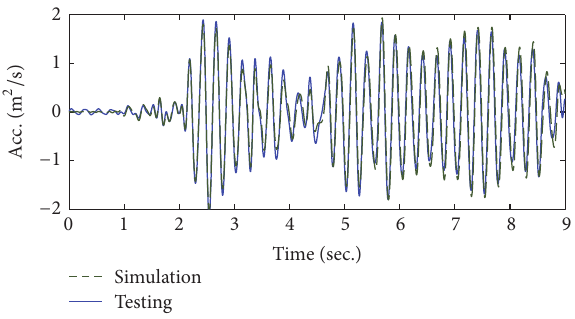
Figure 8: Acceleration of physical substructure measured from the RTDS for one-story frame.